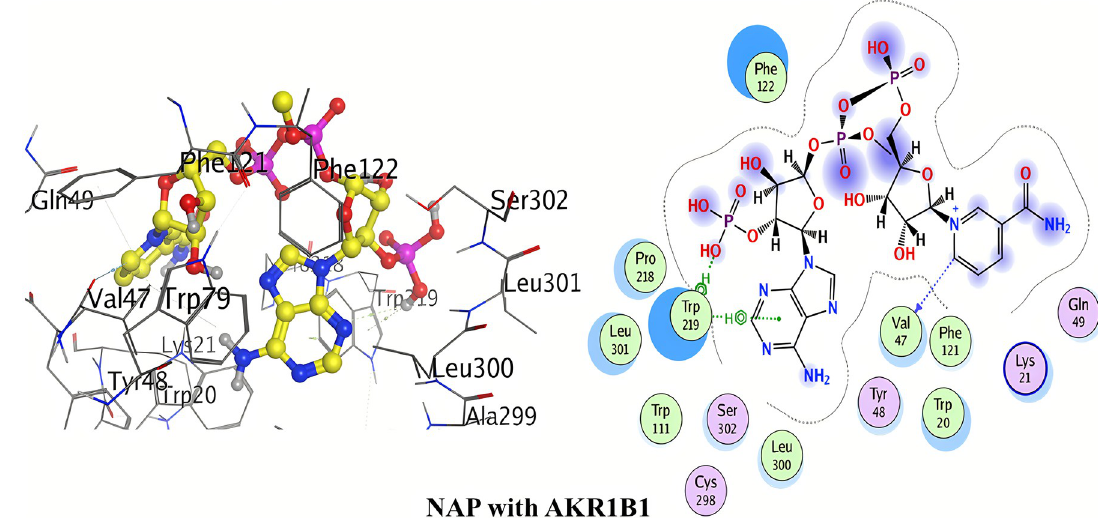
Fig 4. 3D and 2D interactions of Nap (co-crystal ligand) with active site of AKR1B1.